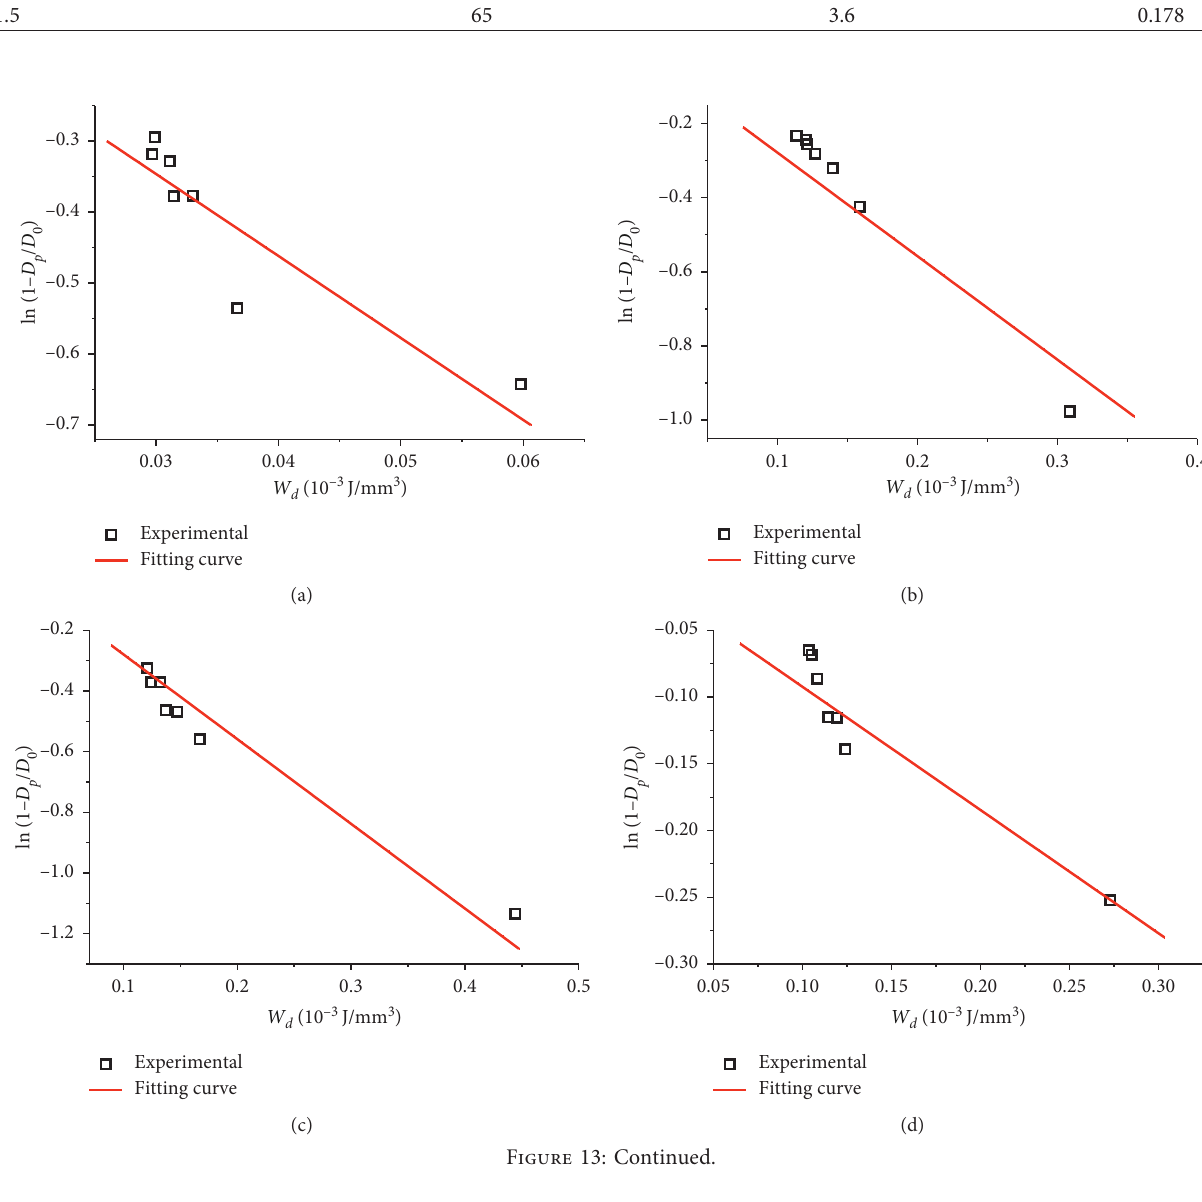
0 and b fitted by using